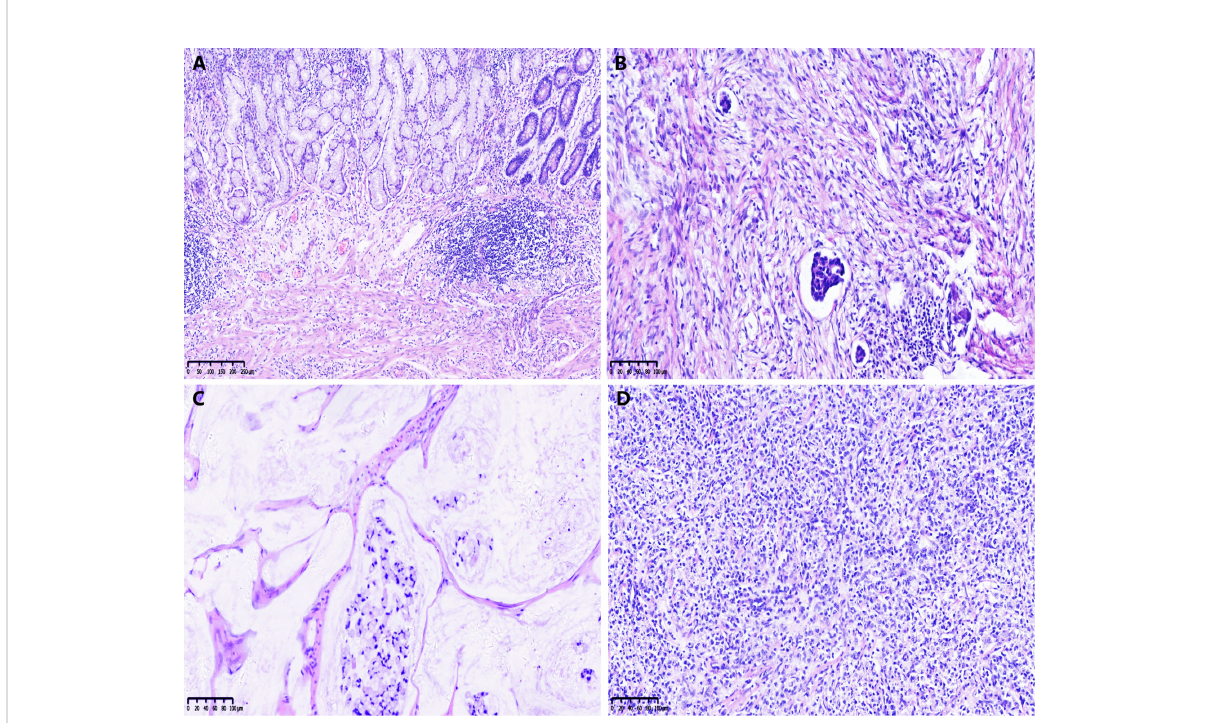
FIGURE 1 Examples of the College of American Pathologists tumor regression grade (CAP-TRG) system. (A) TRG 0, complete tumor regression; (B) TRG 1, rare residual tumor; (C) TRG 2, signi fi cant tumor regression; (D) TRG 3, residual tumor without